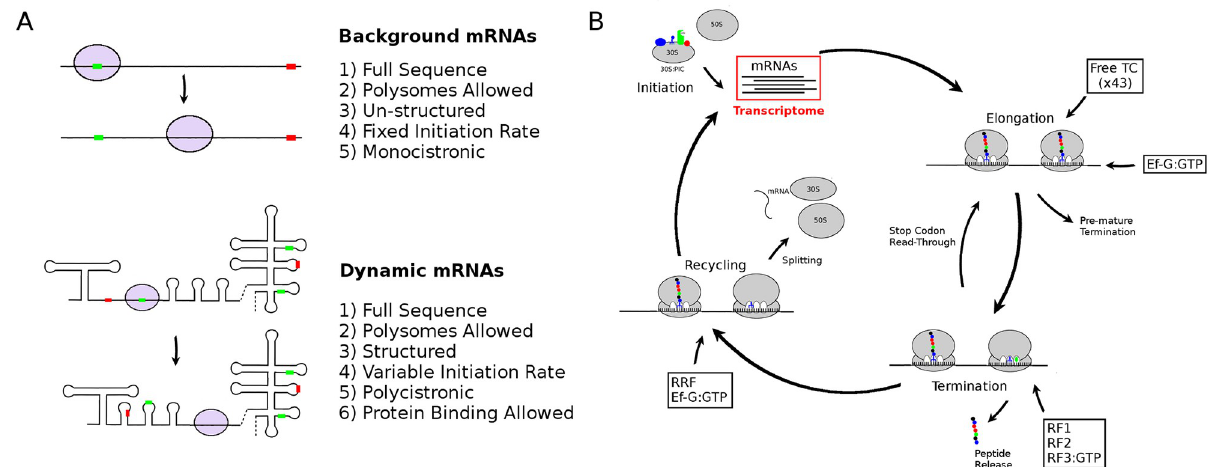
Fig 1. A model of ribosome kinetics on dynamic mRNAs. (A) The transcriptome in the model consists of two types of mRNAs: background mRNAs which are considered as monocistronic with no secondary structure, and dynamic mRNAs which are polycistronic with secondary structure. Initiation rates at potential start codons (green bars, with red bars indicating stop codons) can vary in dynamic mRNAs depending on the current structure around the translation initiation region (TIR) while they are modelled as fixed in the background mRNAs. The movement of the ribosome during elongation is illustrated. (B) The transcriptome is modelled using the framework of the stochastic model in [10], with added RNA folding reactions on the dynamic mRNA.